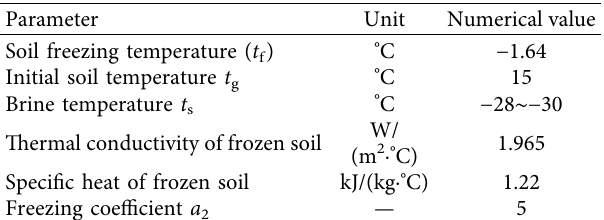
Table 4: Design parameters of the frozen wall of the connecting